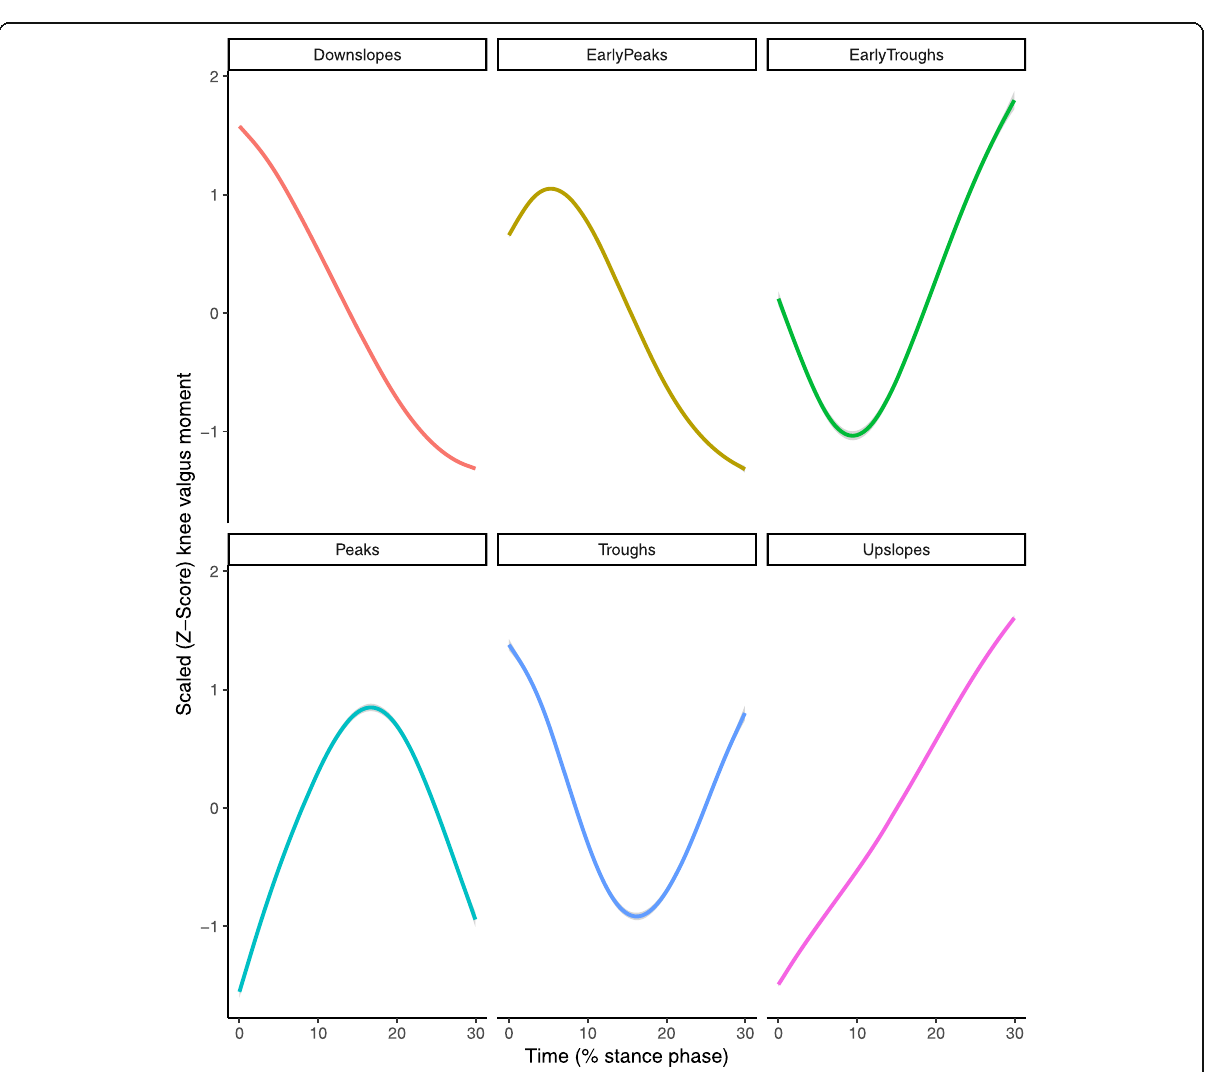
Fig. 4 Smoothed aggregate time series ’ of the six basic shapes of the scaled knee valgus moment curves generated in the initial shape-based cluster analysis. Each time series is individually scaled. The gray shaded area denotes the 95% confidence interval of the smoothing